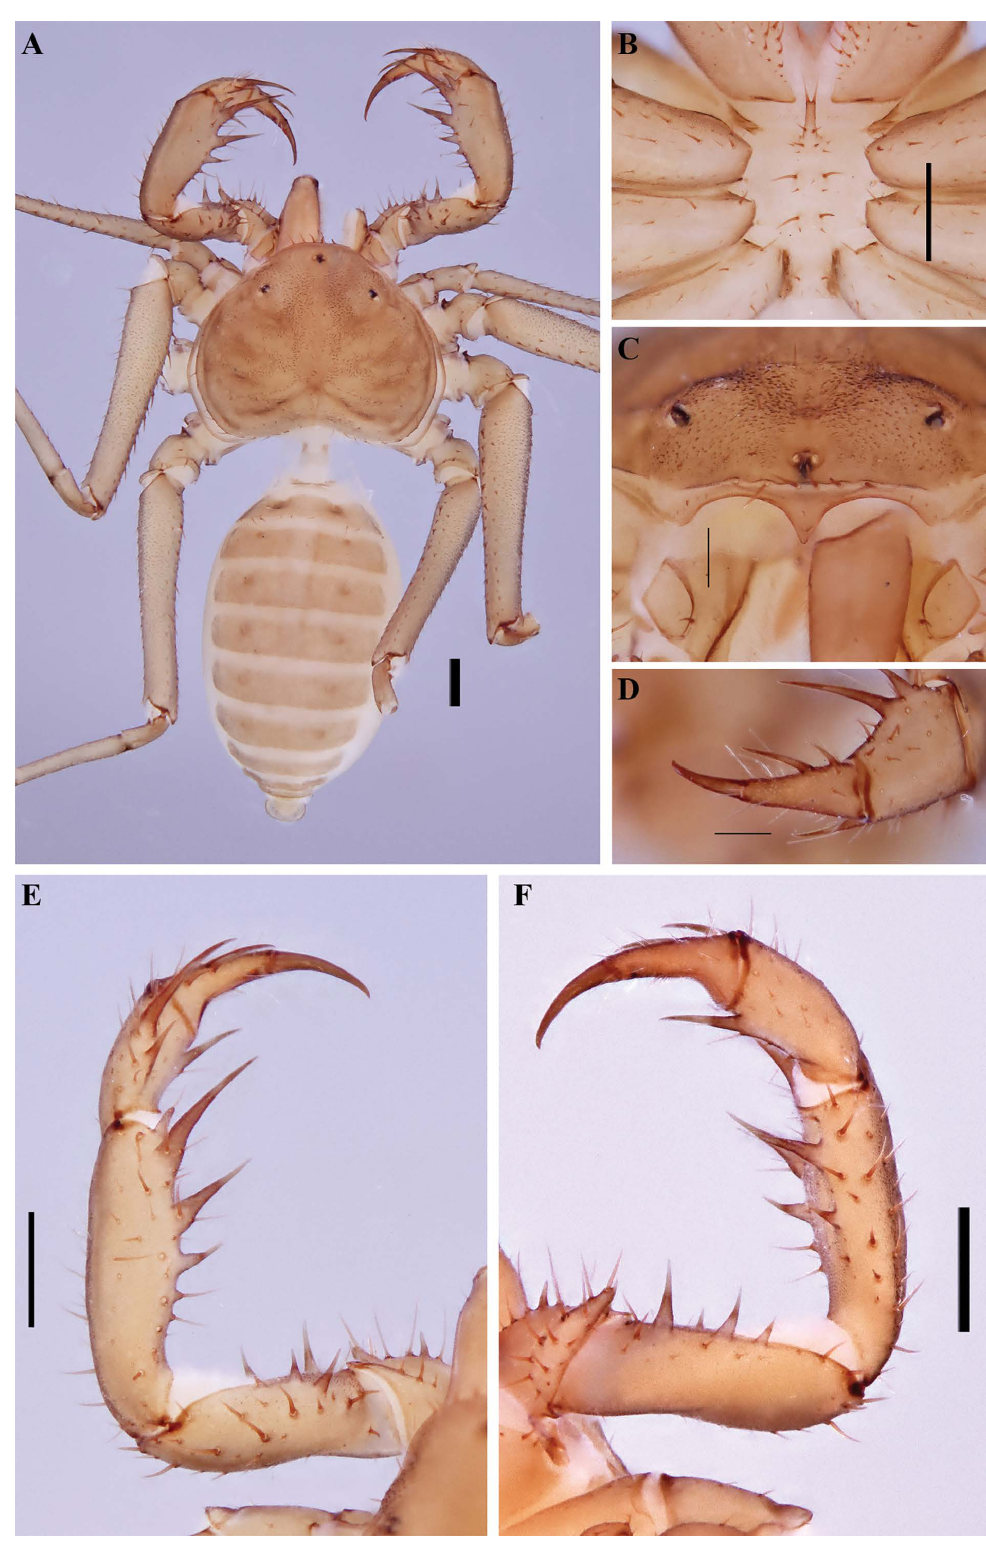
Fig. 35. Charinus guayaquil sp. nov. (MNRJ 9302), general morphology, ♀. A . Habitus, dorsal view. B . Sternum, ventral view. C . Frontal process. D . Pedipalp tarsus, frontal view. E . Pedipalp, dorsal view. F . Pedipalp, ventral view. Scale bars: A–B, E–F = 1 mm; C–D =